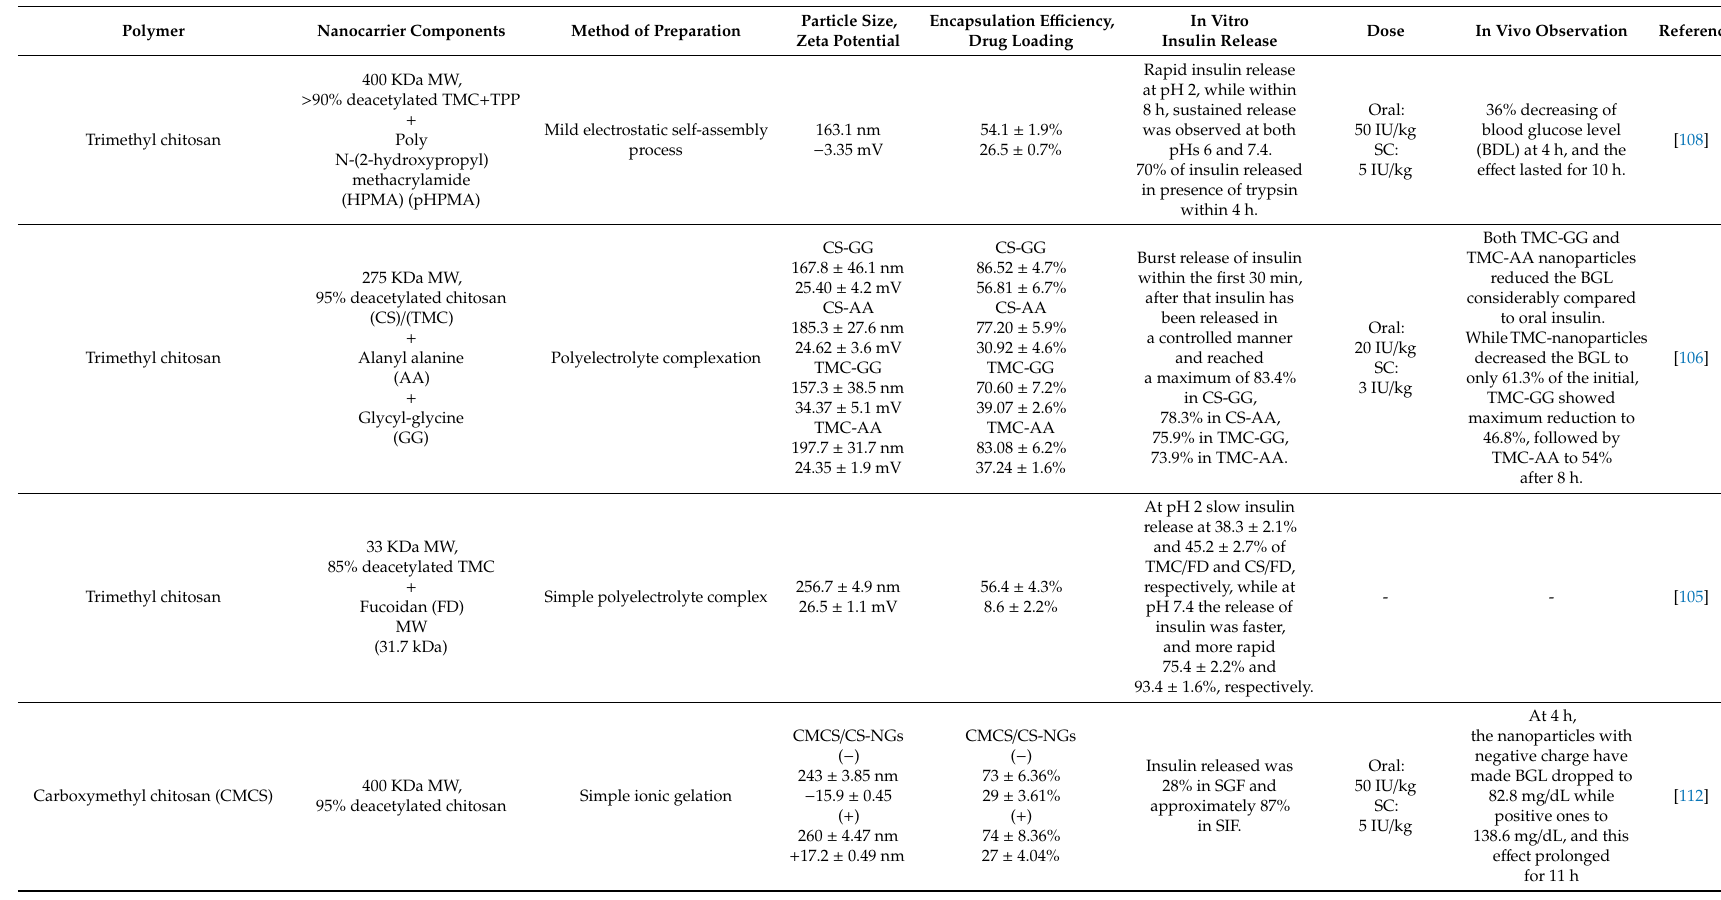
Table 3. Insulin-loaded chitosan derivatives-based